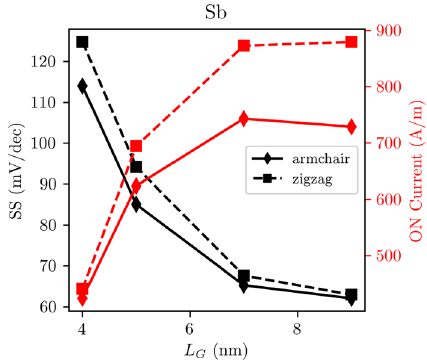
Fig. 5 Figures-of-merit of the Sb-based MOSFETs. ON current and SS as a function of the gate length L G extracted from the transfer characteristics in Fig. 4 of the antimonene-based Figure 4 summarizes the simulated transfer characteristics of the antimonene- and arsenene-based MOSFET for L G varying from 4 to 9 nm, and the transport axis along the armchair and